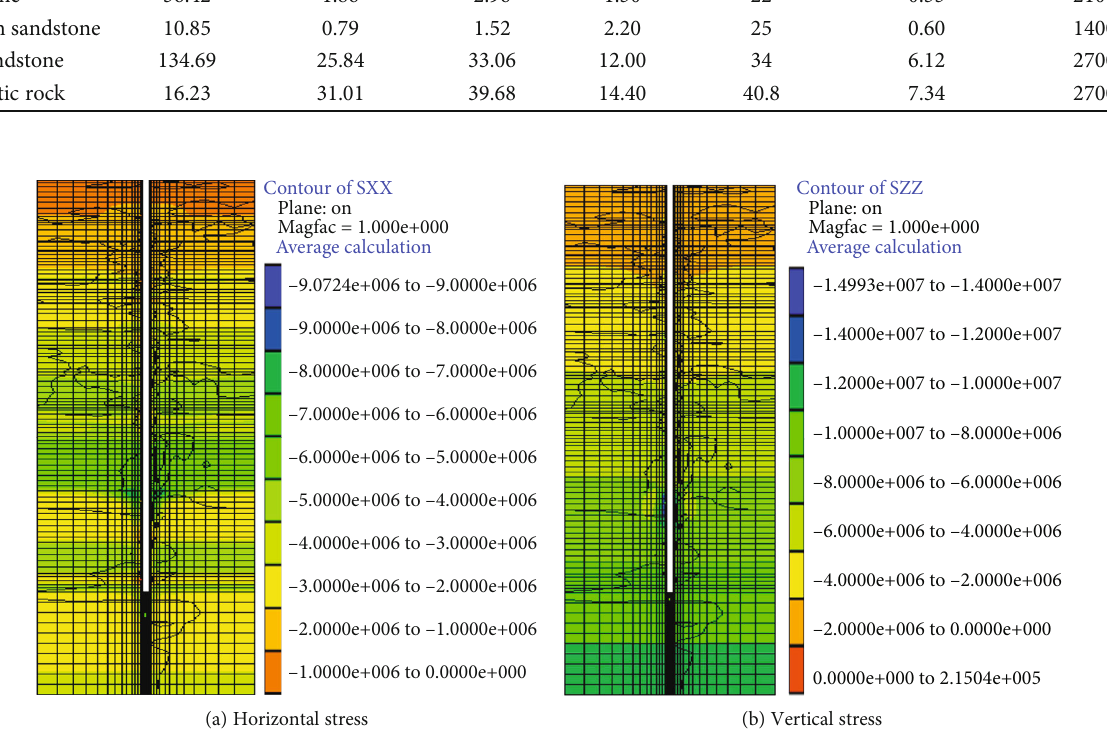
Figure 10: Shaft surrounding rock